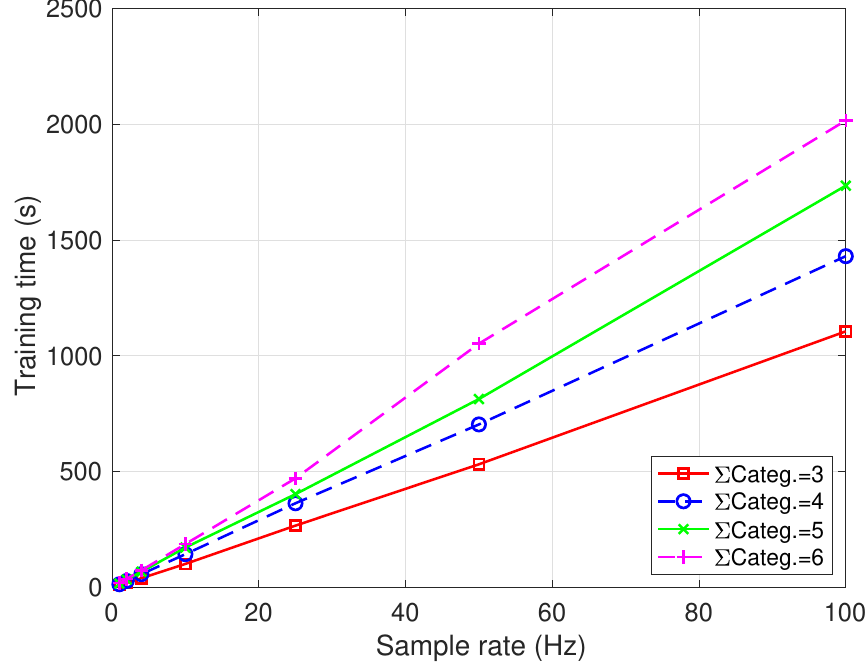
Figure 11. LSTM training time versus sample-rate. Sensor = acceleration, no. of hidden units = 150, solver = ADAM.